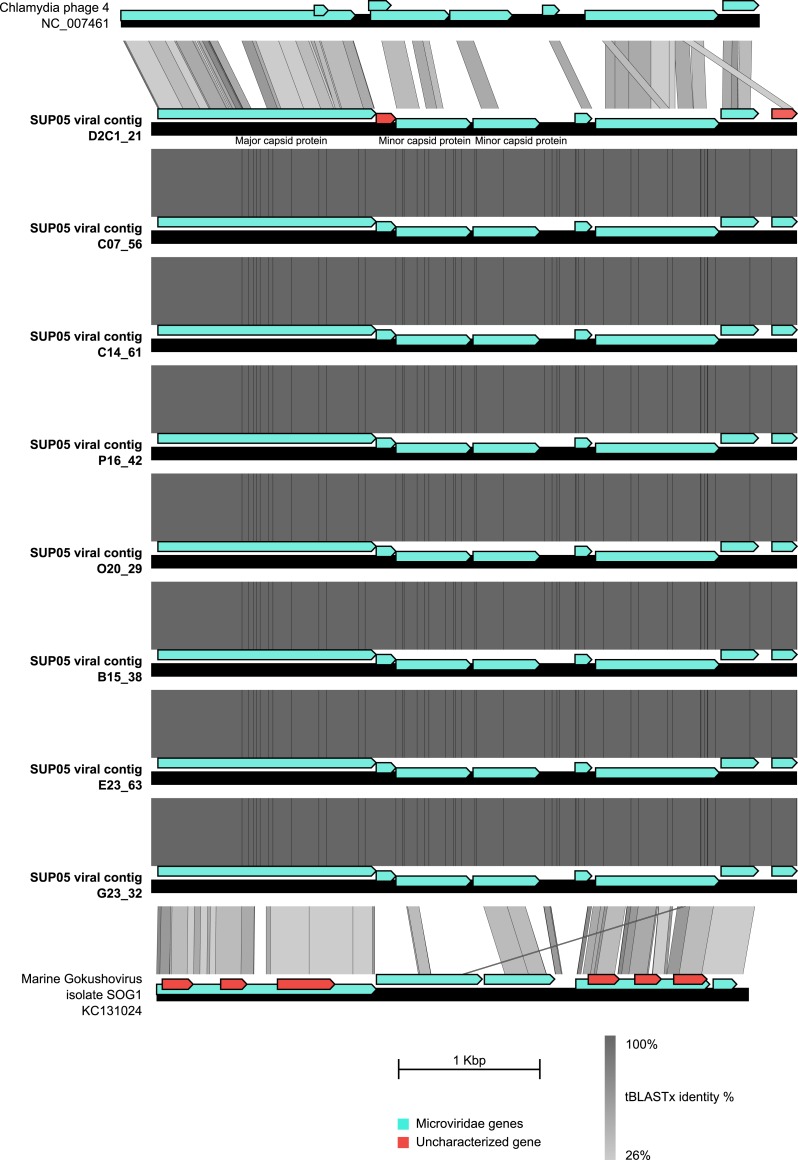
Genetic map and synteny plots for the SUP05 Microviridae reference.Viral hallmark genes are labeled on the plot. Associated sequence ‘Marine Gokushovirus isolate SOG1-KC131024’ was sampled from Strait of Georgia (Labonté and Suttle 2013b), on which the Saanich Inlet fjord is opening.